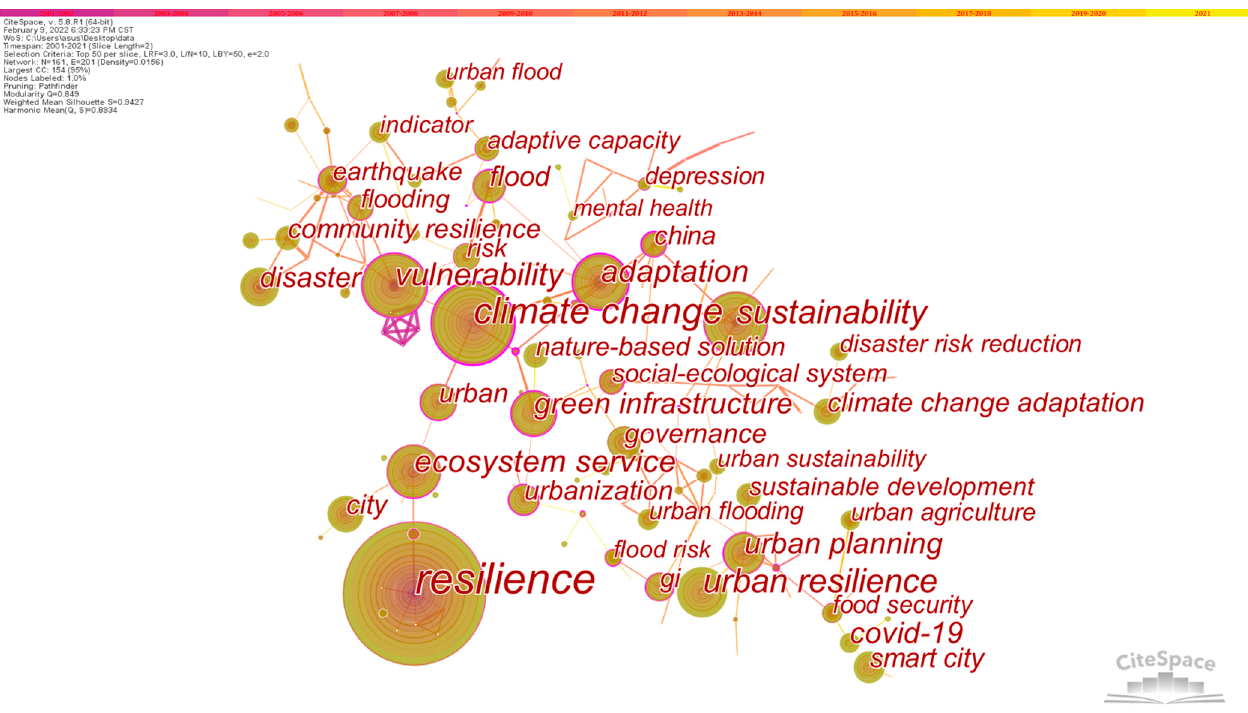
Figure 7. Collaborative co-occurrence map for RC keywords.